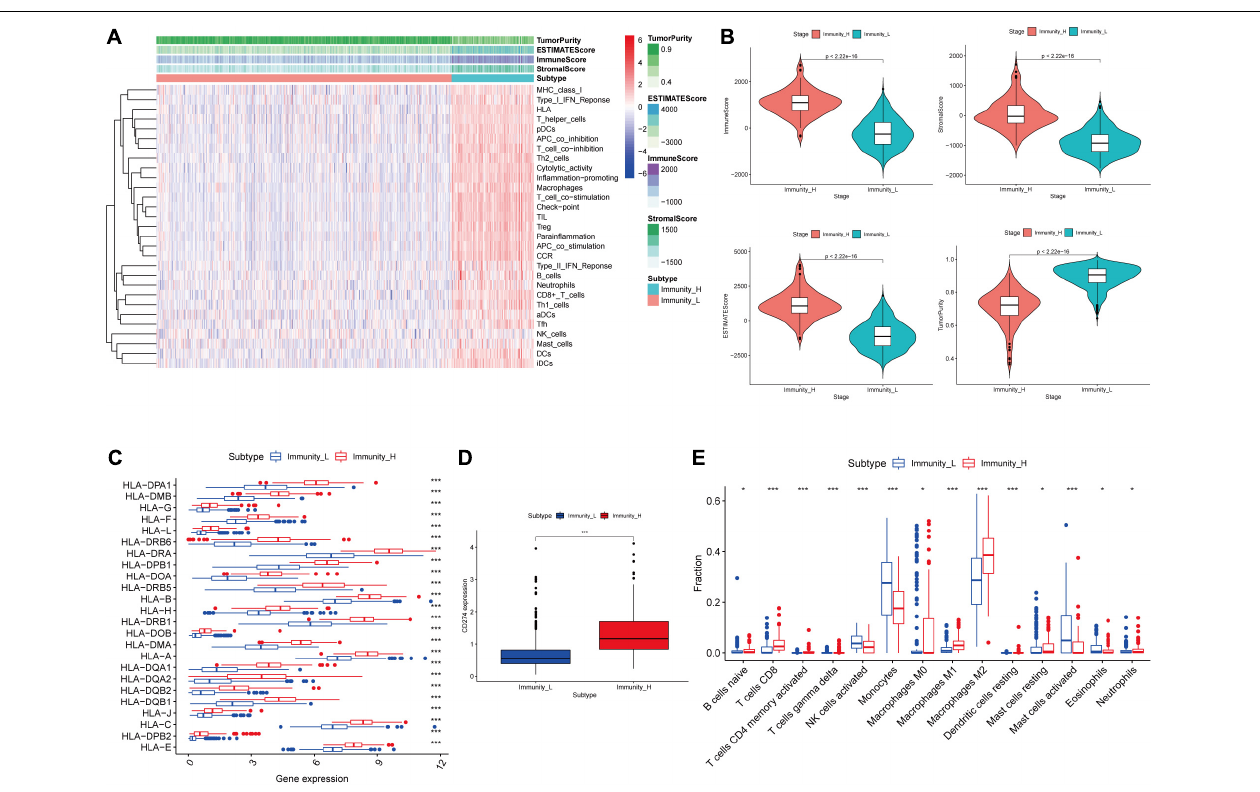
FIGURE 1 | Construction and validation of glioma grouping. (A) The display of tumor purity, ESTIMATE score, immune score, and stromal score of each sample gene calculated by ESTIMATE’s algorithm between the high immune infiltration group and the low immune infiltration group. (B) The boxplot showed a statistical difference between the two groups in tumor purity, ESTIMATE score, immune score, and stromal score. (C,D) The expression of HLA family genes and CD274 between the two groups. (E) The proportion difference of immune cells calculated by CIBERSORT method between the two groups. “Immunity_H” and “Immunity_L” represent the high immune cell infiltration group and the low immune cell infiltration group, respectively; * p < 0.05 and *** p < 0.001.